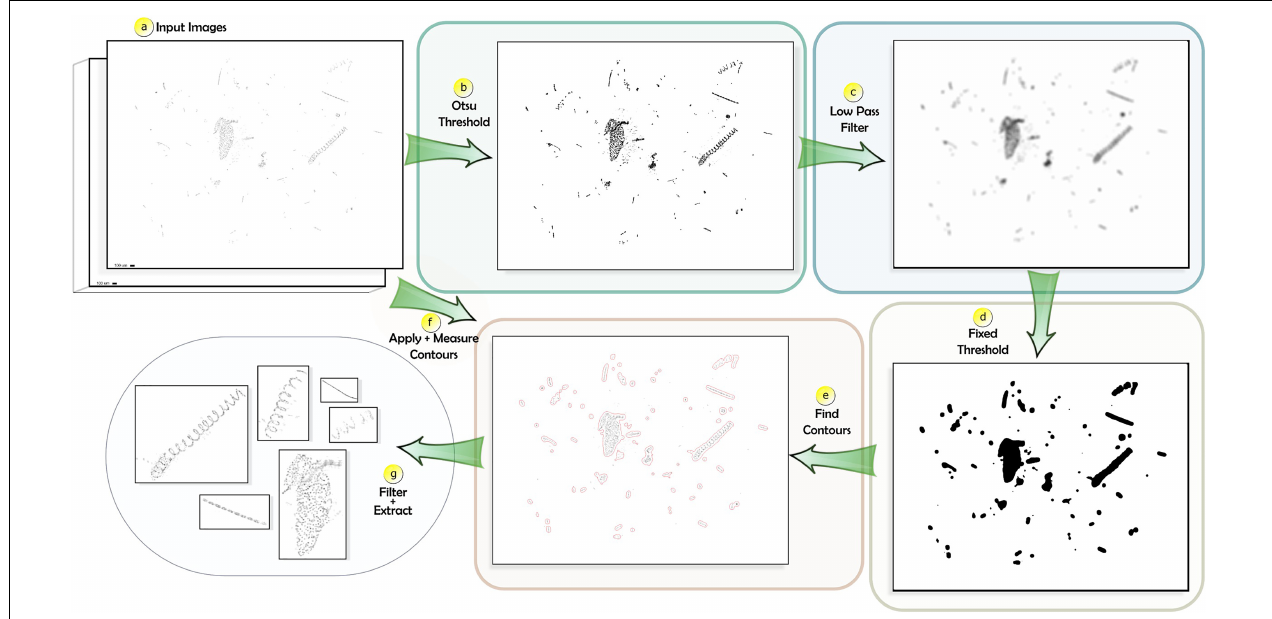
FIGURE 1 | Planktonator segmentation and particle extraction workflow. (a) Input reconstructed images from HoloBatch, (b) Otsu threshold to find the most prominent pixels, (c) low pass filtering to connect neighboring pixels, (d) fixed threshold and flood fill to define particle regions, (e) contour calculation, (f) application of contours and particle measurement, (g) particle filtering and